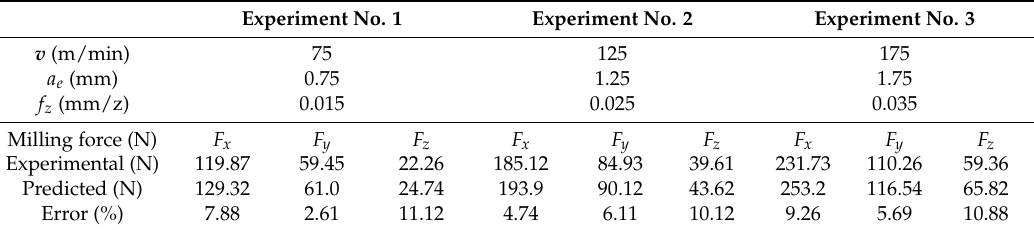
Table 12. Test of regression model for milling